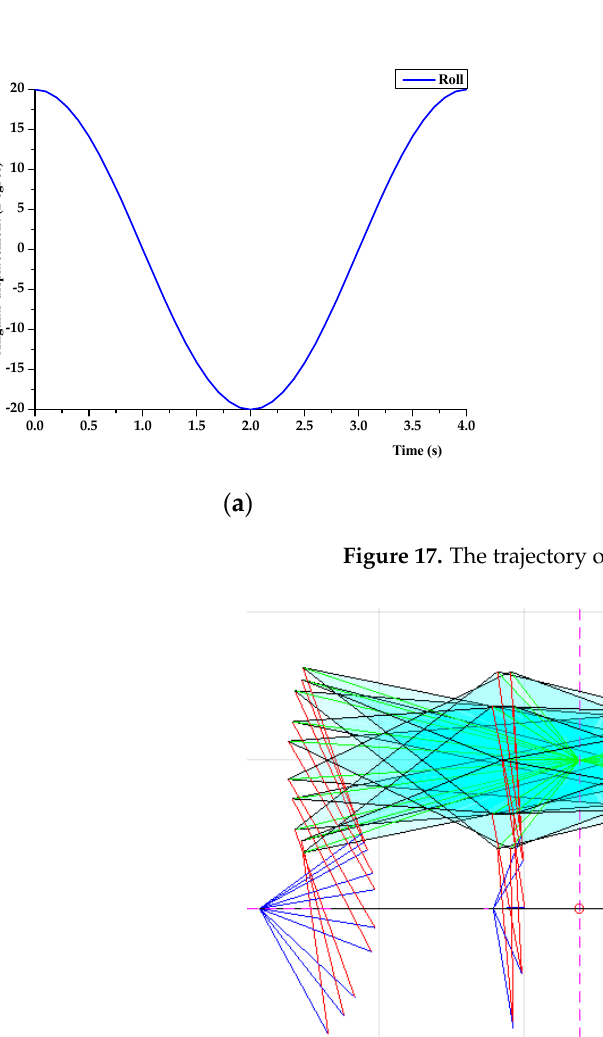
Figure 18. Multi-axis motion platform trajectory model.